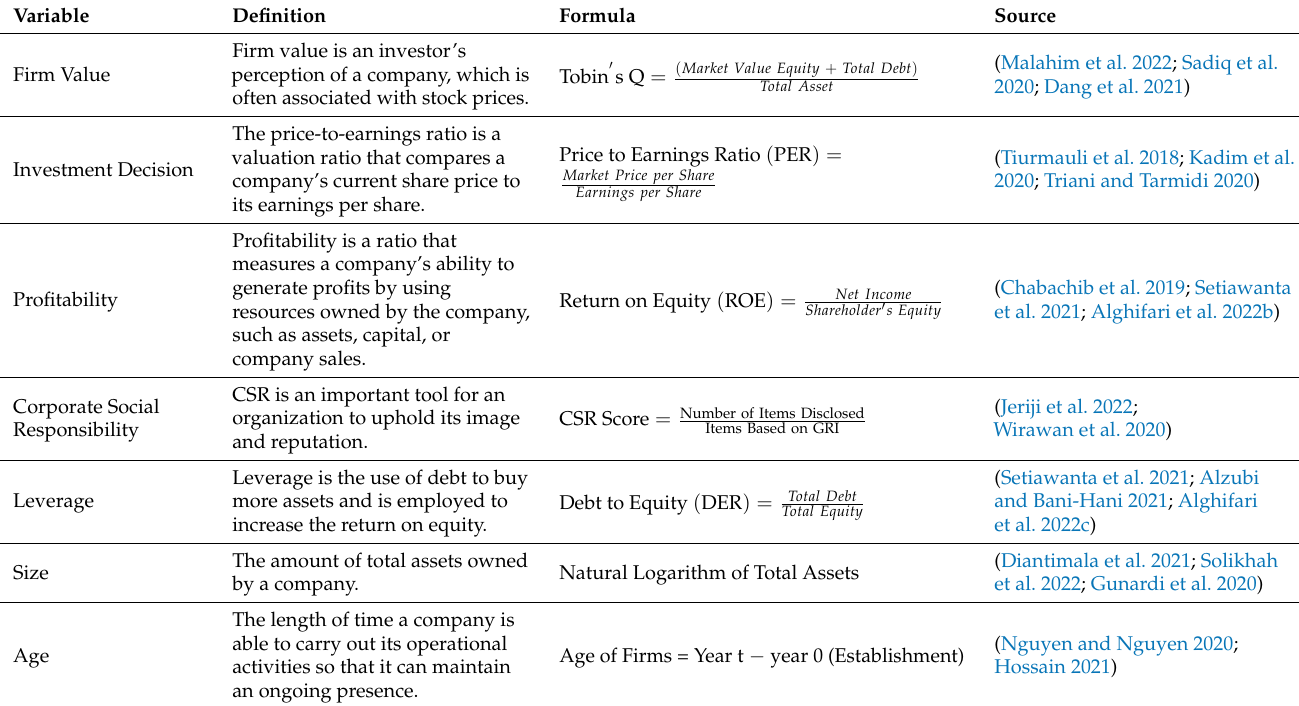
Table 1. Variable